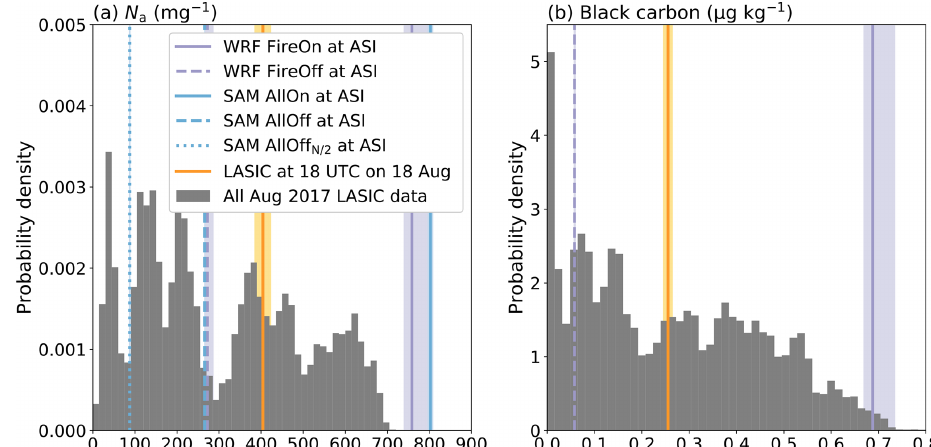
Figure 20. Comparison of August 2017 LASIC statistics to model output. The distributions of all August 2017 observations of (a) accumulation-mode aerosol number concentration and (b) black carbon mass concentration from the LASIC ground site are shown as grey histograms. Means and interquartile ranges are indicated by lines and shading, respectively, for the LASIC observations (yellow), WRF output (purples), and the SAM output (blues) subset around 18:00UTC on 18 August